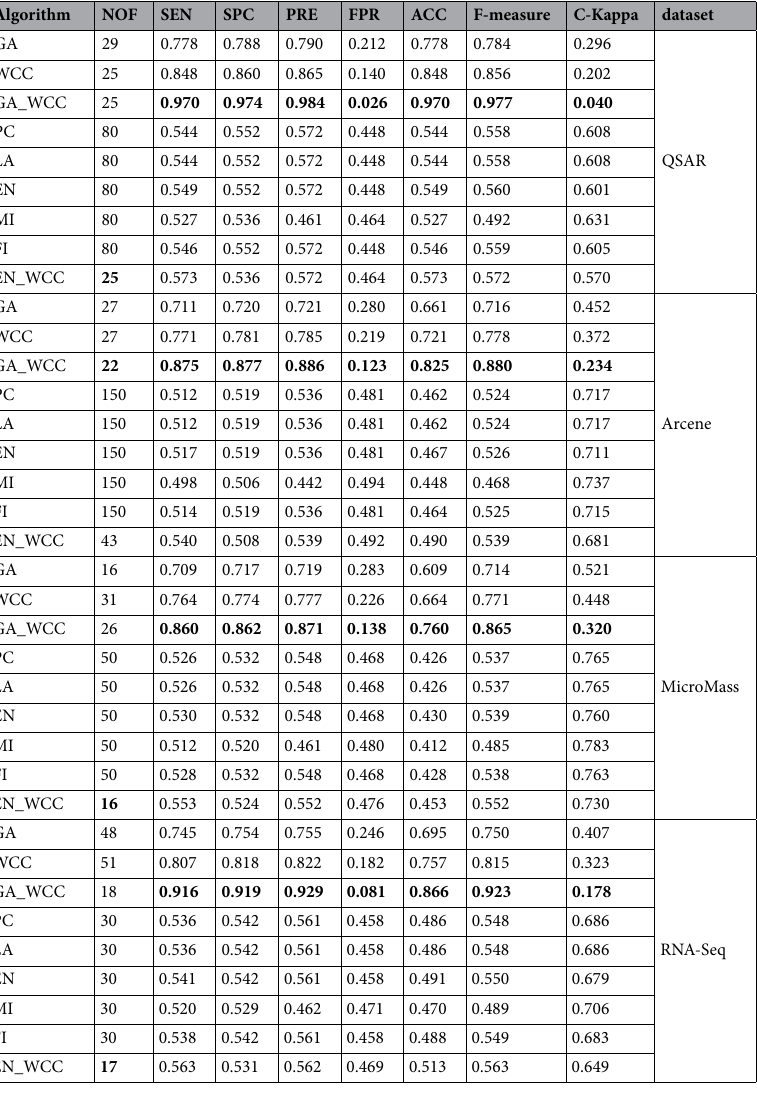
Table 3. Acquired outcomes based on fivefold cross-validation in the first class of results on the QSAR, Arcene, MicroMass, and RNA-Seq datasets. The best outcomes have been highlighted. NOF, number of features; SEN, sensitivity; SPC, specificity; PRE, precision; FPR, false positive rate; ACC, accuracy; C-Kappa, Cohen’s kappa coefficient; WCC, world competitive contests algorithm; GA, genetic algorithm; PC, Pearson correlation; LA, Laplacian score; EN, entropy; MI, mutual information; FI, Fisher